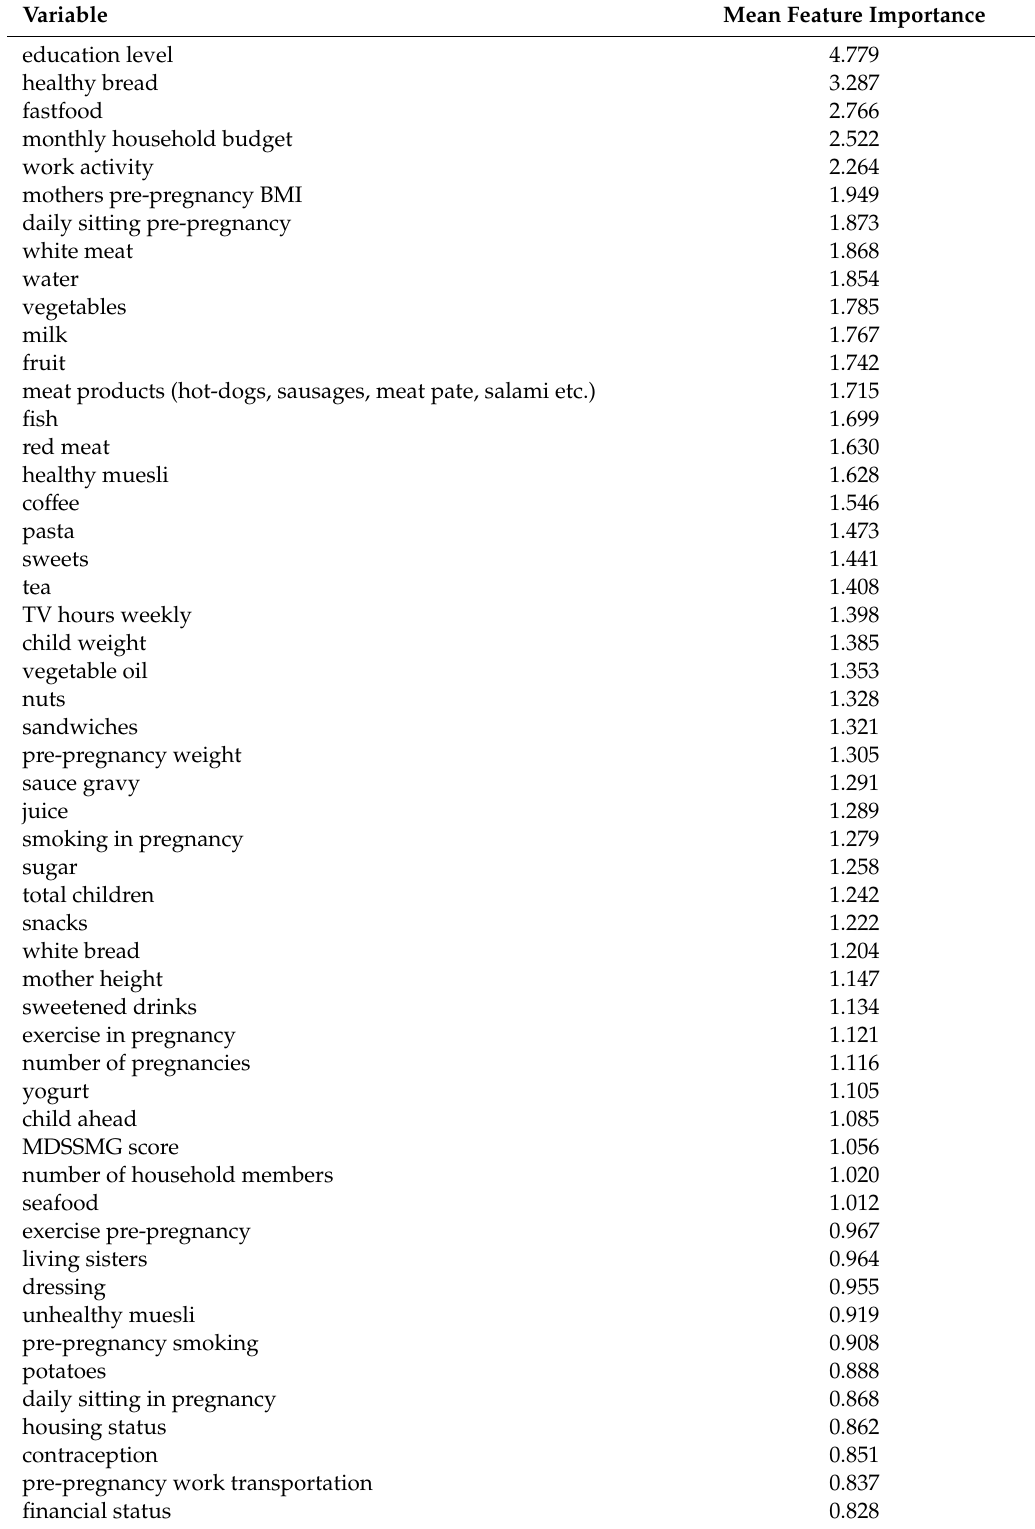
Table A3. Full variable importance